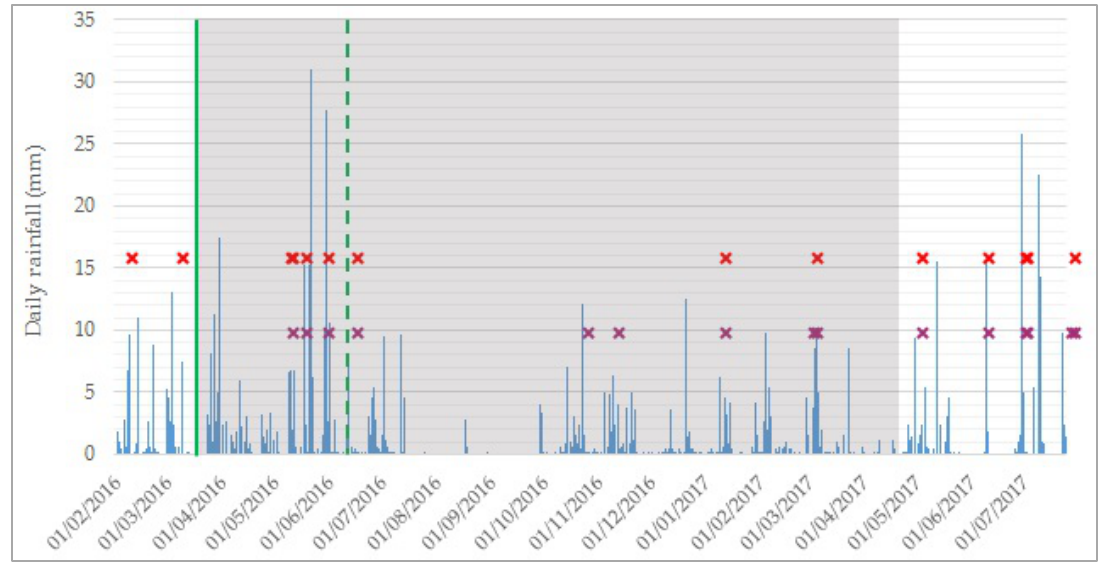
Figure A1. Timeline of sampled events with daily rainfall shown in blue. Sampling events of road runoff (RR) are represented in red, while those in the BFS drain are shown in purple; note that some events sampled in close succession appear as a single mark. The mass balance period is shown in grey, the solid green line represents the installation of filter media in the biofiltration swale and the dotted green line represents installation of the check dams.